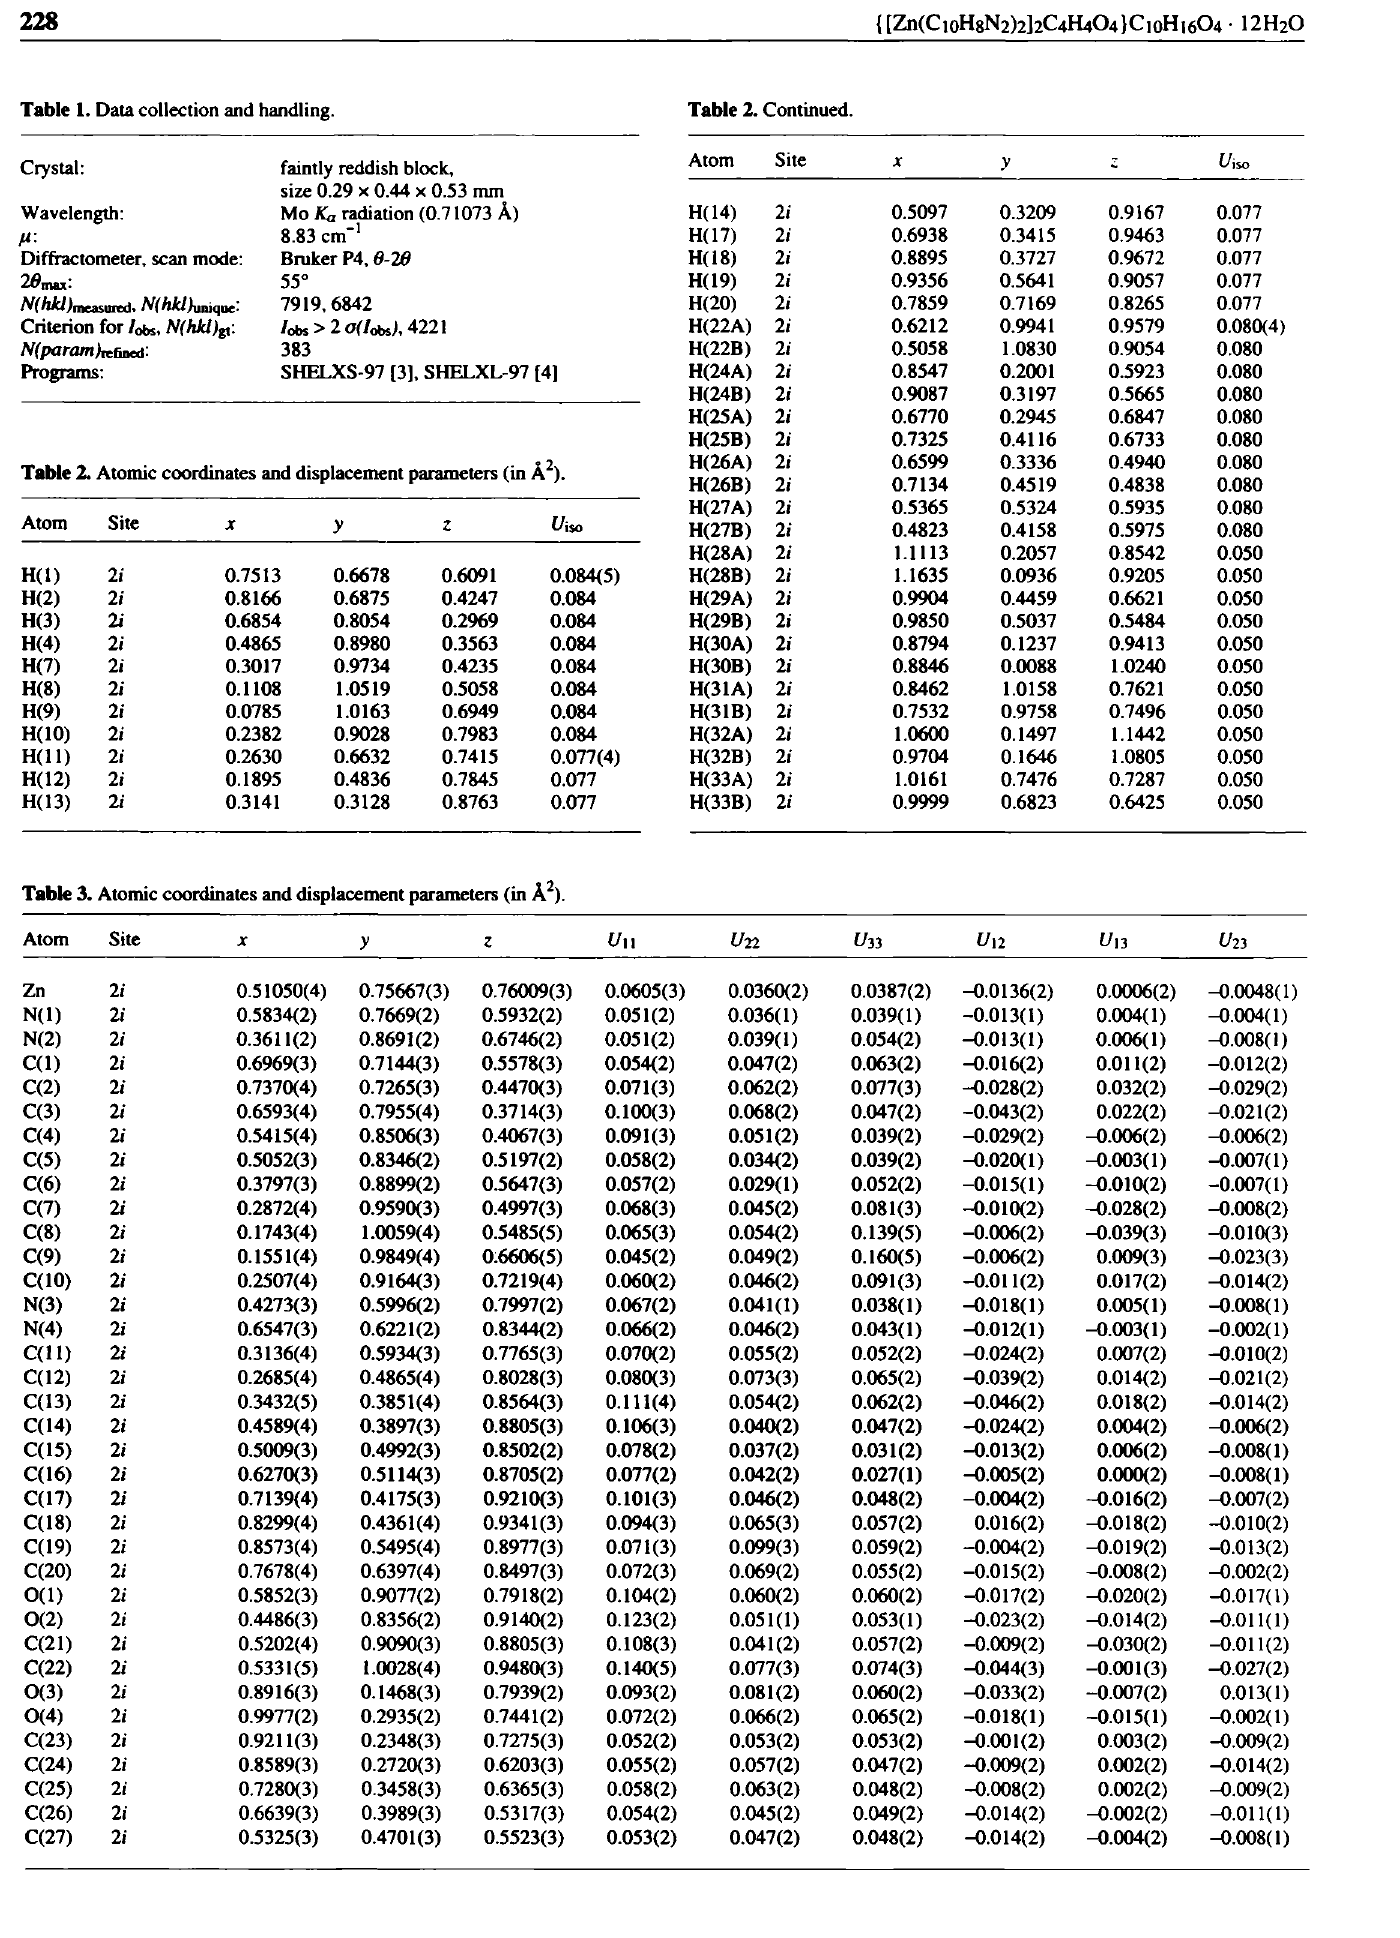
Table 1. Data collection and handling. Table 2. Continued.